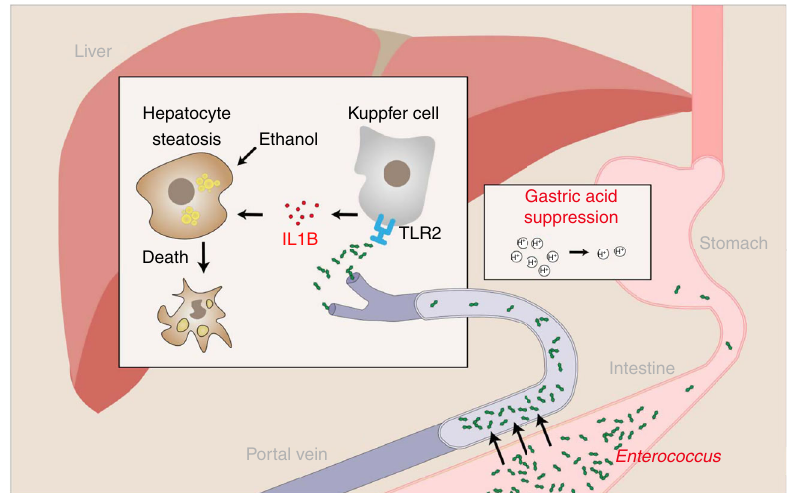
Fig. 10 Gastric acid suppression and alcoholic liver disease. Gastric acid suppression increases intestinal Enterococcus , which translocates to the liver via the portal vein. Enterococcus binds to the pathogen recognition receptor TLR2 on hepatic Kupffer cells, leading to secretion of IL1B. IL1B contributes to ethanol- induced liver in fl ammation and hepatocyte For conditioned medium and IL1B neutralization experiments, Kupffer cells normalized to 16S rRNA concentrations. One sample collected before PPI were cultured with RPMI 1640 medium containing 10% FBS (vv − 1 ) for 4h and administration and two collected afterward had too low DNA concentrations and serum starved in DMEM/F-12 (Thermo Fisher Scienti fi c) with insulin-transferrin- could not be ampli fi ed by qPCR. Written informed consent was signed by each selenium (1% v v − 1 ) (Thermo Fisher Scienti fi c) and 40ngml − 1 dexamethasone participant after the nature and possible consequences of the studies were (MP Biomedicals) overnight. Kupffer cells were then stimulated with heat- explained. The study protocol was approved by the Institutional Review Board inactivated and sonicated E. faecalis (MOI 25) for 8hours with the same culture from each institution involved. medium containing 10% FBS (v v − 1 ). Cell supernatants were transferred to hepatocytes, and incubated for 24h. A neutralizing antibody against IL1B (10ngml − 1 ;